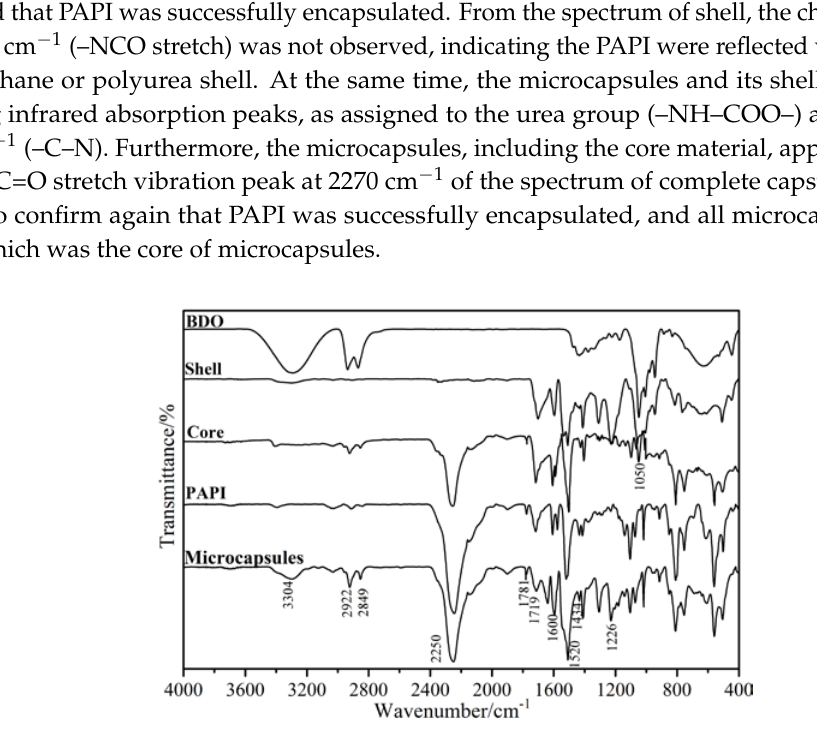
Figure 8. FTIR spectra of microcapsules, capsules shell, capsule core, 1,4-Butanediol (BDO) and polyaryl polymethylene isocyanates (PAPI).